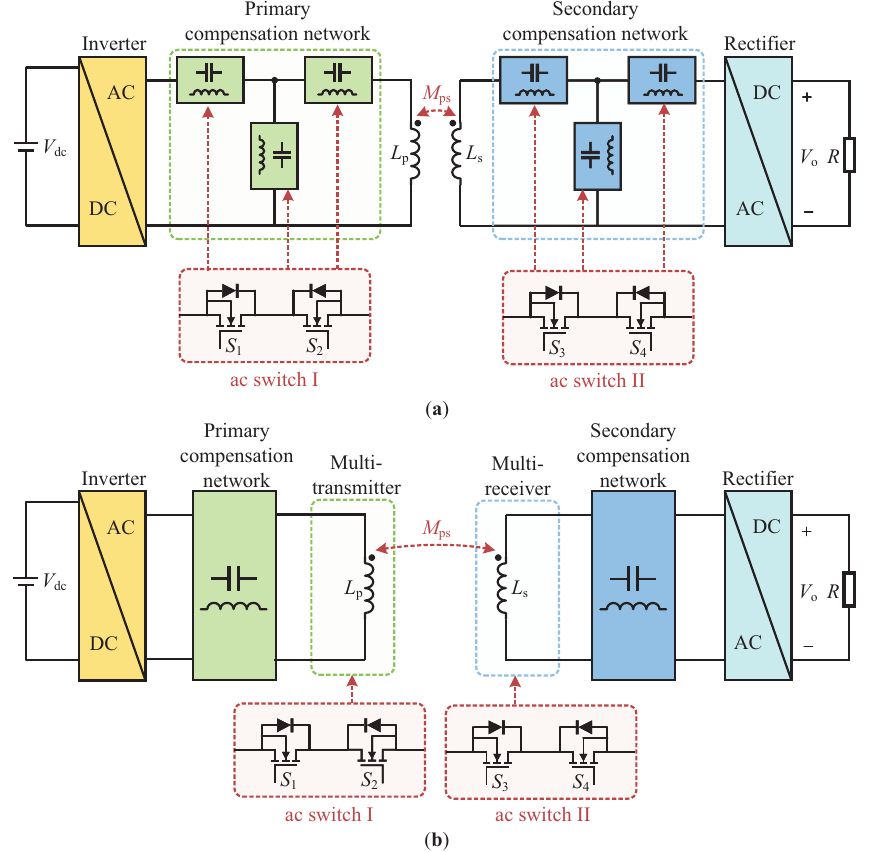
Figure 1. Schematic of the reconfigurable topologies with ( a ) switchable topologies/components and ( b ) switchable multiple